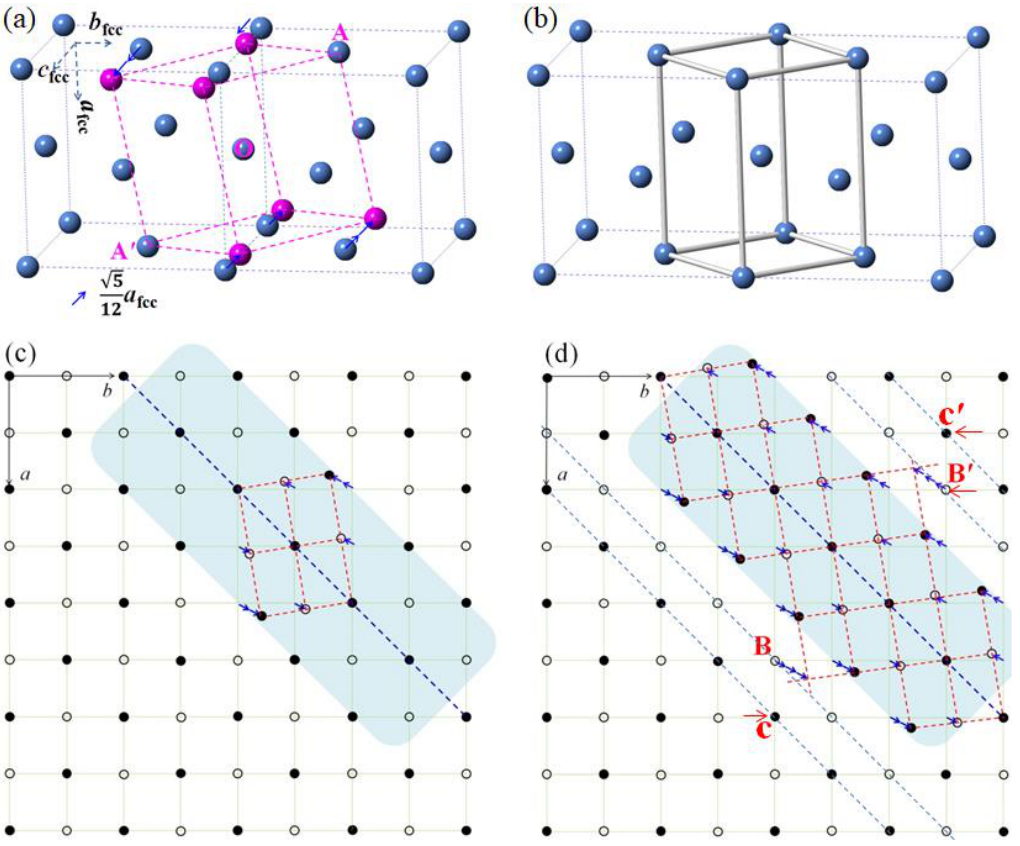
Figure 7. Schematic representation of the γ → α transformation process: ( a ) the model in [30]. Gray dots are the fcc-Fe atoms; the pink one is bcc-Fe, and some are not shifted at the positions of A, O, and A ′ . One arrow indicates that the atom shifts a distance of ( √ 5/20) a fcc-Fe along the arrow direction (one of the <110> directions in {100} planes). ( b ) Bain model. The atoms connected by bars are the atoms, which should transform into bcc-Fe. ( c ) The projection of ( a ) along the c fcc-Fe direction. The atoms connected with red dashed lines are bcc-Fe atoms. The arrows are the same in ( a , d ). ( d ) All atoms in the shadow region transformed into bcc-Fe structure. Double or triple arrows correspond to the atoms that have shifted two or three times of one arrow distance along the arrow direction, respectively. The open circles and dots are in different layers in ( c , d ).